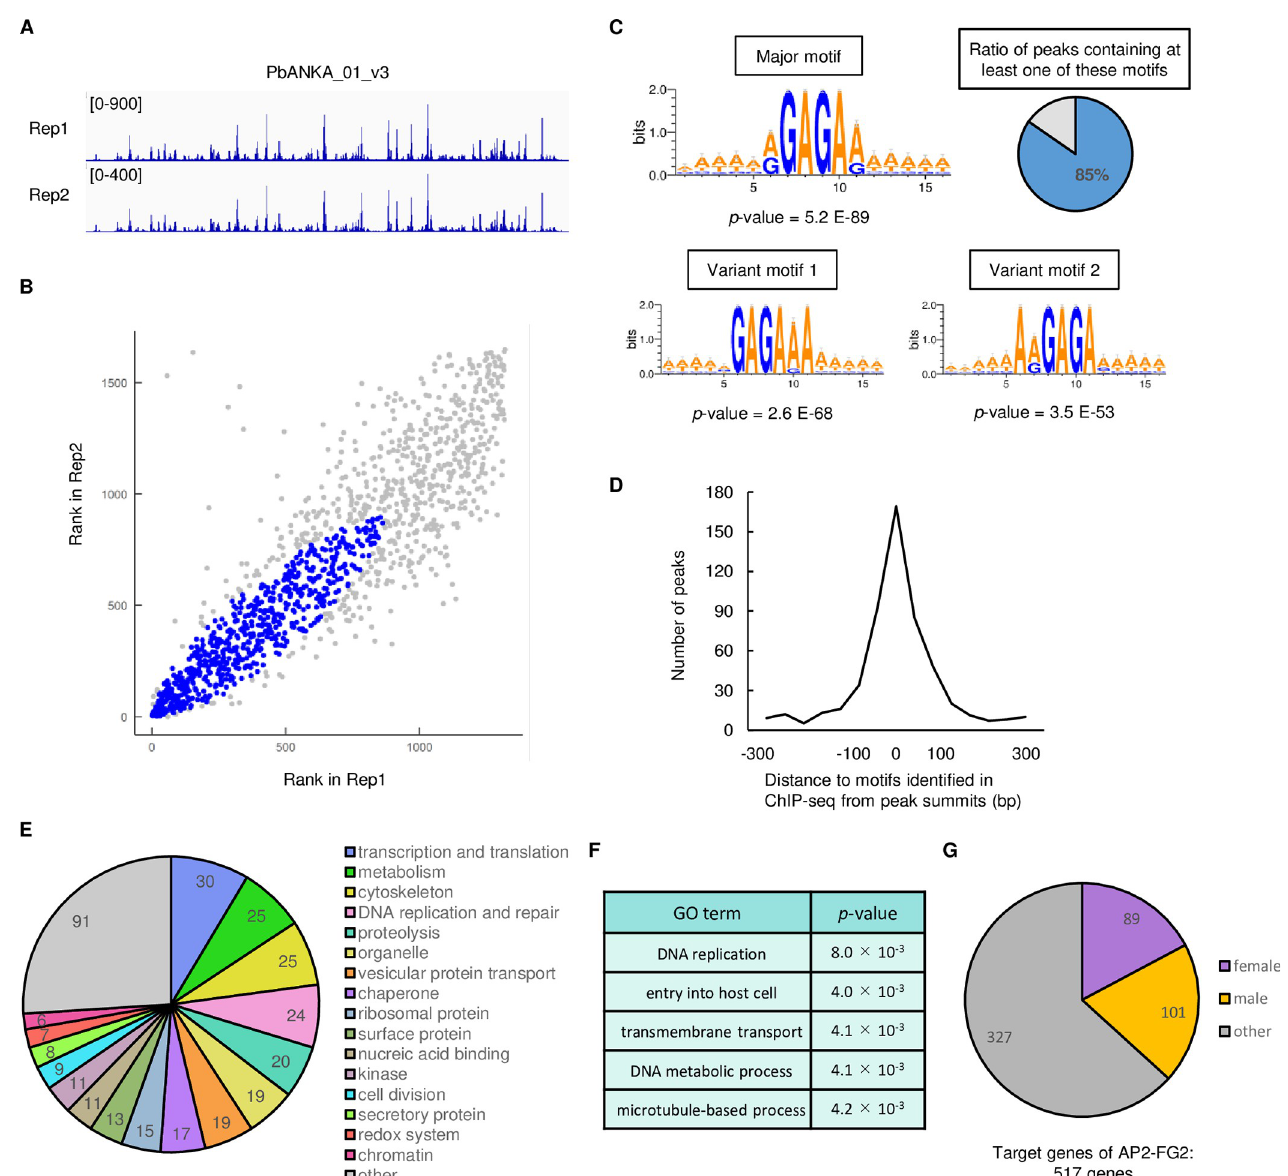
Fig 3. ChIP-seq analysis using Pb AP2-FG2::GFP. (A) IGV images showing peaks identified in the ChIP-seq experiment 1 and 2 of Pb AP2-FG2 on the chromosome 1. Read coverage for the ChIP data is shown. (B) IDR1D analysis between the ChIP-seq experiment 1 and 2. The rank of peaks according to their p -value for each experiment is plotted against each other. Peaks with IDR < 0.01 are indicated as blue dots. (C) Motifs enriched within 50 bp from peak summits identified in the ChIP-seq of Pb AP2-FG2. The logos were depicted using WebLogo 3 (http://weblogo.threeplusone.com/). Percentage of the peaks that had at least one of these motifs within 300 bp from the summit is indicated as a pie graph in the top left corner. (D) Distance between peak summits and the nearest major or variant motifs. (E) Classification of target genes into 17 groups according to their functional annotation. (F) Gene ontology analysis for target genes of Pb AP2-FG2. Terms with p -value < 0.01 are shown. (G) Classification of target genes of Pb AP2-FG2 into sexual stage-enriched gene